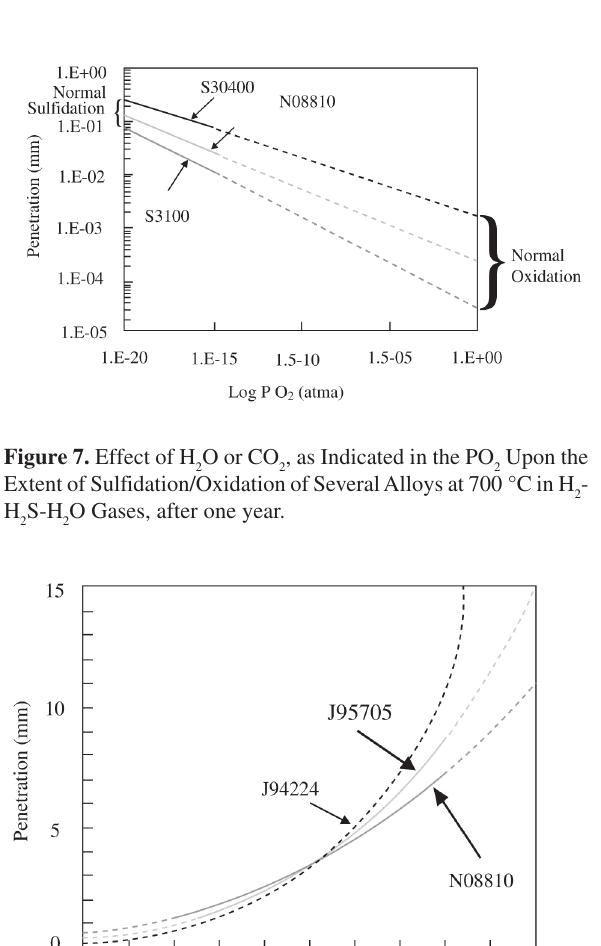
Figure 8. Effect of Temperature Upon Carburization of Several Alloys Exposed to Solid Carbon and 2 × 10 -4 atma H Year.